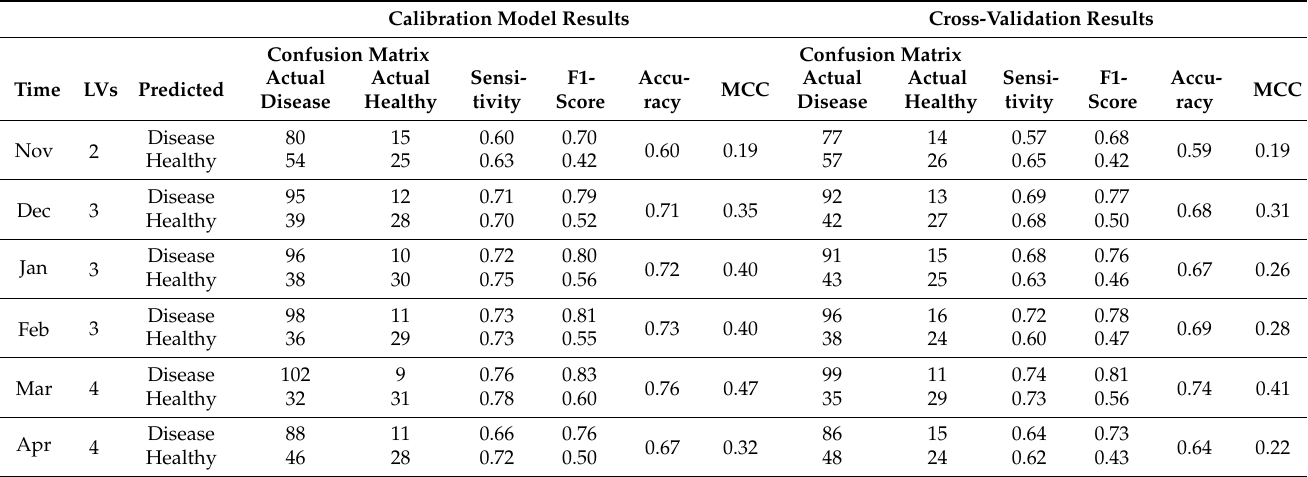
Table 2. PLS-DA results for Chardonnay. Sample number: Disease = 134, Healthy = 40.